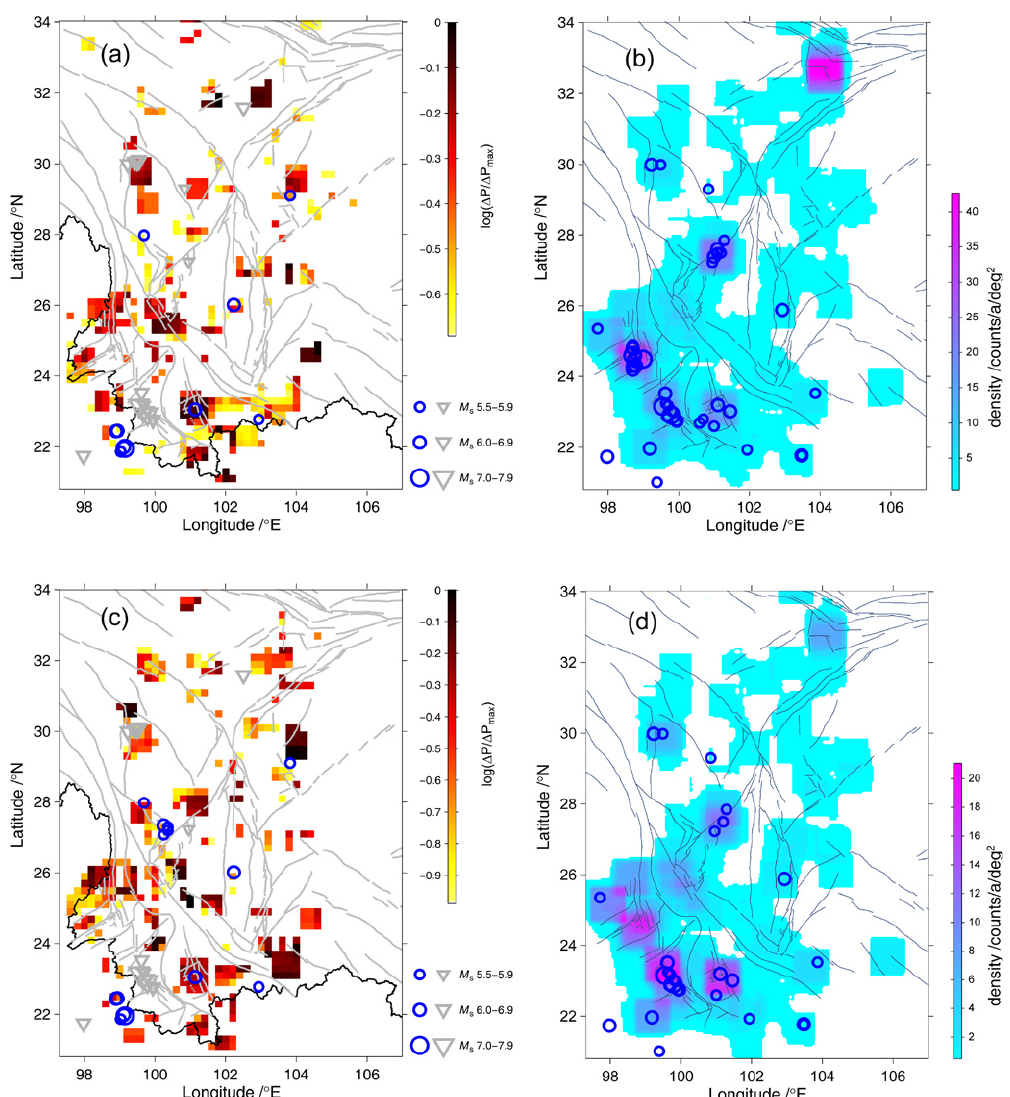
Fig. 9. Hotspot maps of the PI algorithm using “clustering” events. (a) Hotspot map with t 2 =1 January 1991. (b) Clustering seismicity rate for events used in panel (a) , shown by clustering seismic activity ˆ C(x,y) . (c) Hotspot map with t 2 =1 January 1992. (d) Clustering seismicity rate for events in the sliding window used in panel (c)